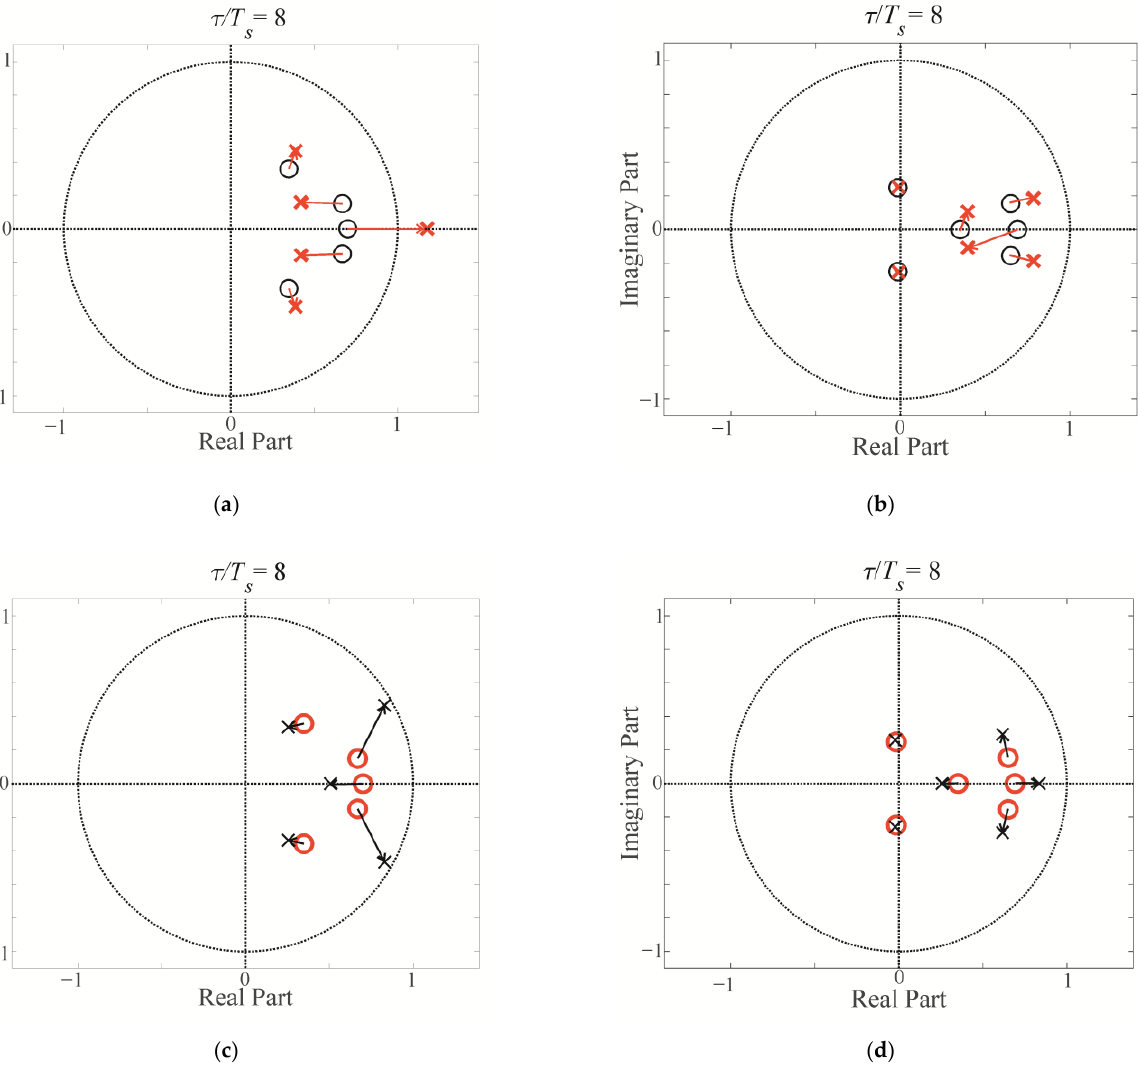
Figure 4. Pole shifts of the closed-loop CDM system (with L F = 2 mH, C F = 51 μF, and τ = 8 T s ), showing ( a , b ) a system configured for R CDM = R se = 2 Ω (black circles) subjected to a decrease in R se to 0.4 Ω (red crosses), and ( c , d ) a system configured for R CDM = R se = 0.4 Ω (red circles) subjected to an increase in R se to 2 Ω (black crosses); ( a ) S ( z −1 ) order 2, R ( z −1 ) order 2, P z ( z −1 ) order 5; ( b ) S ( z −1 ) order 2, R ( z − 1 ) order 3, P z ( z −1 ) order 6 (given additional plant delay); ( c ) S ( z −1 ) order 2, R ( z −1 ) order 2, P z ( z −1 ) order 5; ( d ) S ( z −1 ) order 2, R ( z −1 ) order 3, P z ( z −1 ) order 6 (given additional plant delay).